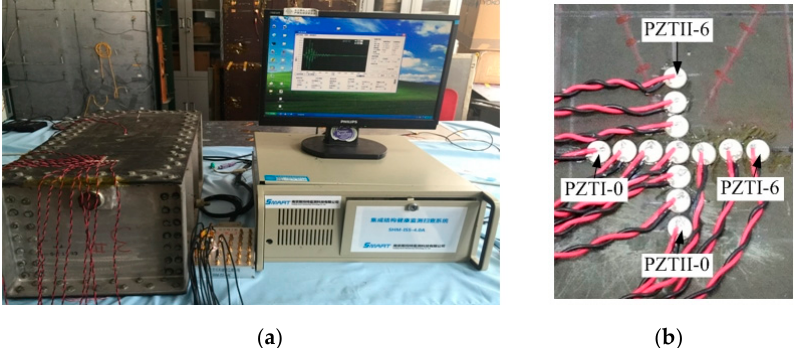
Figure 5. The experimental setup. ( a ) The experimental system ( b ) The cross-array and its numbered components.